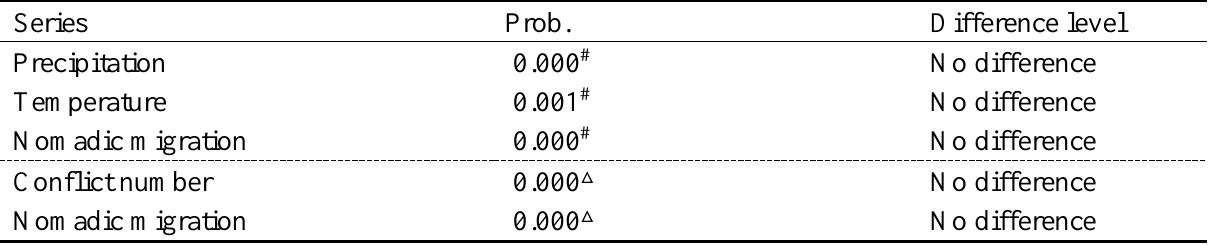
Table A3 Augmented Dickey–Fuller test in Granger causality analysis of “climate change  nomadic migration  conflicts between pastoralists and